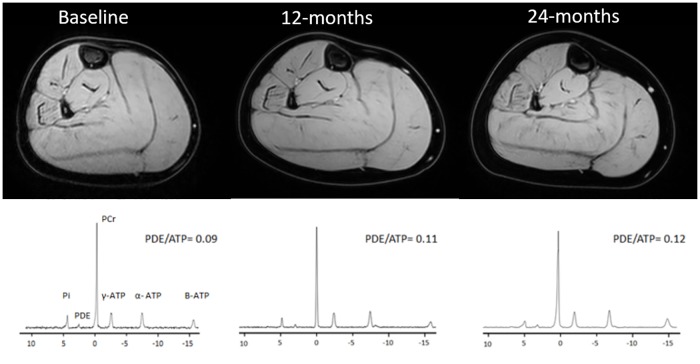
Representative reconstructed water images of the right lower leg and phosphorous spectra of the TP muscle of a DMD patient at baseline, 12-months and 24-months.PDE-levels in TP muscles are presented in the graph and %fat for the all analyzed muscle for all three time points are stated here: (Baseline GCL:5.6%;GCM:7.3%; SOL: 7.1%; PER:14,4%; TA: 6.24%; TP: 4.2%; 12-months: GCL: 6,6%; GCM:8.8%; SOL: 5.2%; PER:20.6%; TA: 5.71%; TP: 4.3%; 24-months: GCL:10.1%; GCM:11.3% SOL: 5.9%; PER:24.7%; TA: 7.3%; TP: 4.3%).